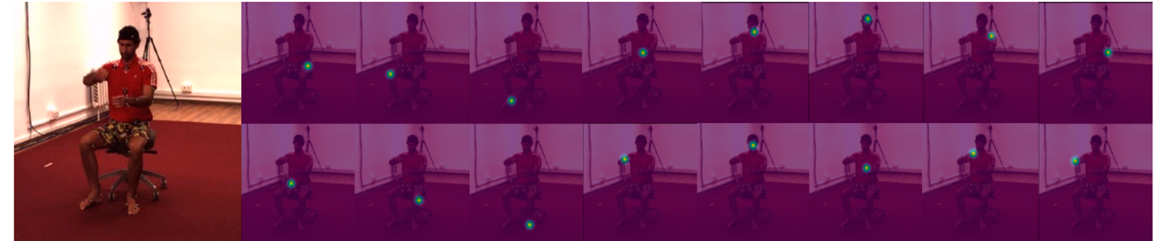
Figure 12. Heatmap visualization of each joint of the model in an image from the Human3.6M dataset.